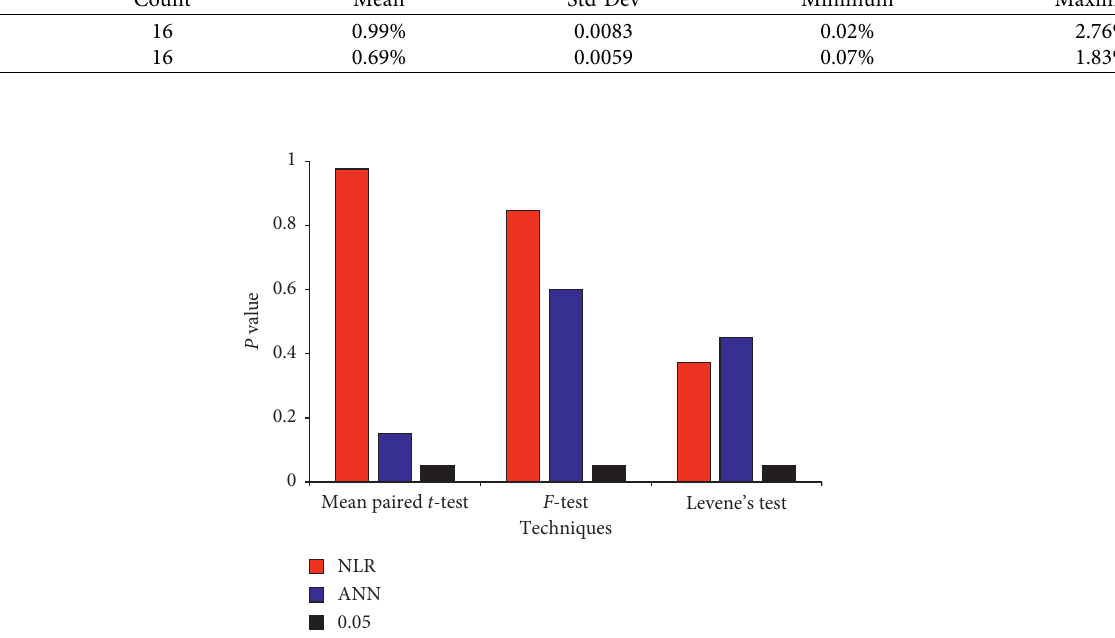
Figure 6: Descriptive statistics of hypothesis